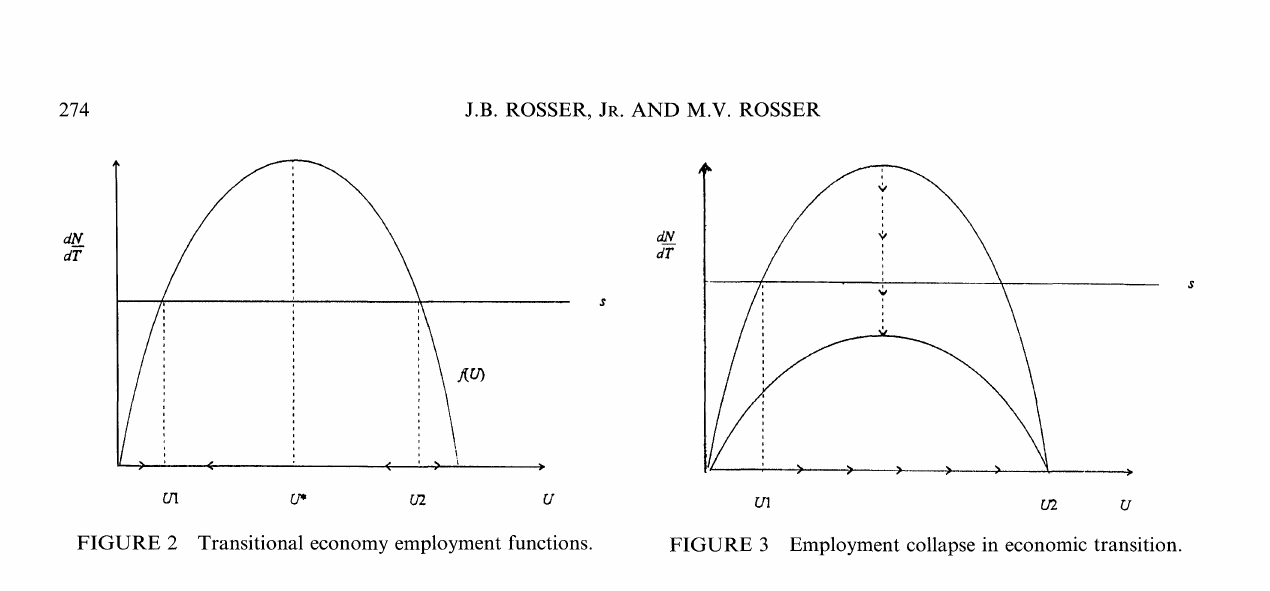
FIGURE 2 Transitional economy employment functions. FIGURE 3 Employment collapse in economic